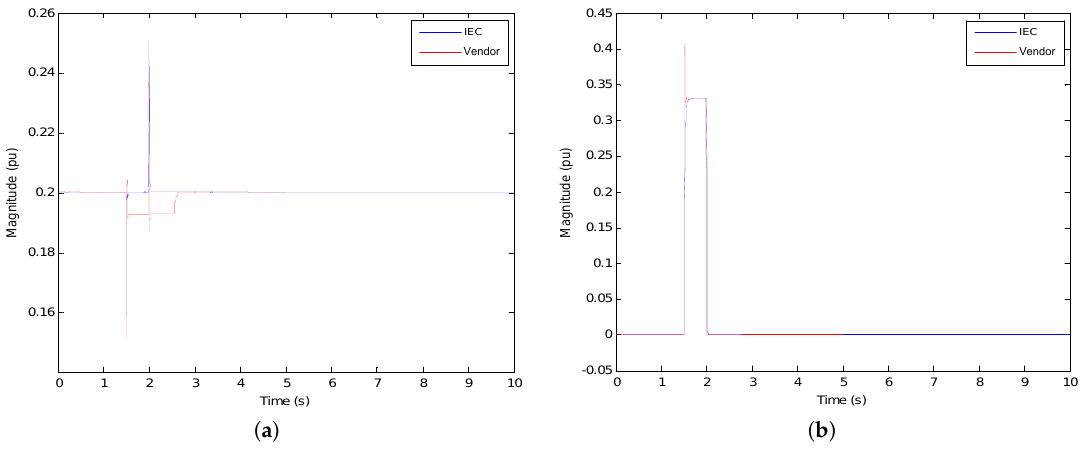
Figure 12. Type IVA results. Simulation scenario: p = 0.20 pu, u = 0.85 pu, t = 500 ms. ( a ) Active power, p ; and ( b ) reactive current, i q